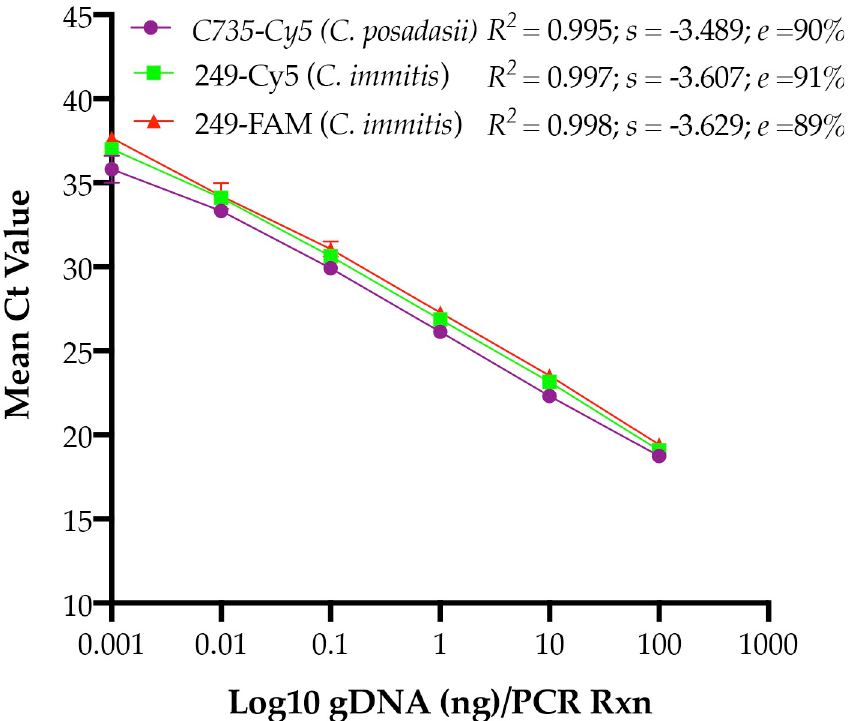
Fig 2. Coccidioides duplex real-time PCR assay sensitivity. Genomic DNA from two control strains of Coccidioides species, C . immitis (249) and C . posadasii (C-735) were serially diluted and tested in triplicate in duplex real-time PCR assay. The assay was linear over 5 orders of magnitude and the limit of detection was 0.001 ng or 1 picogram gDNA/ PCR reactions at 45 PCR cycles confirming high sensitivity. As indicated, the assay targeting CiC gene did not yield Ct values against C . posadasii DNA. The test was repeated with similar results.